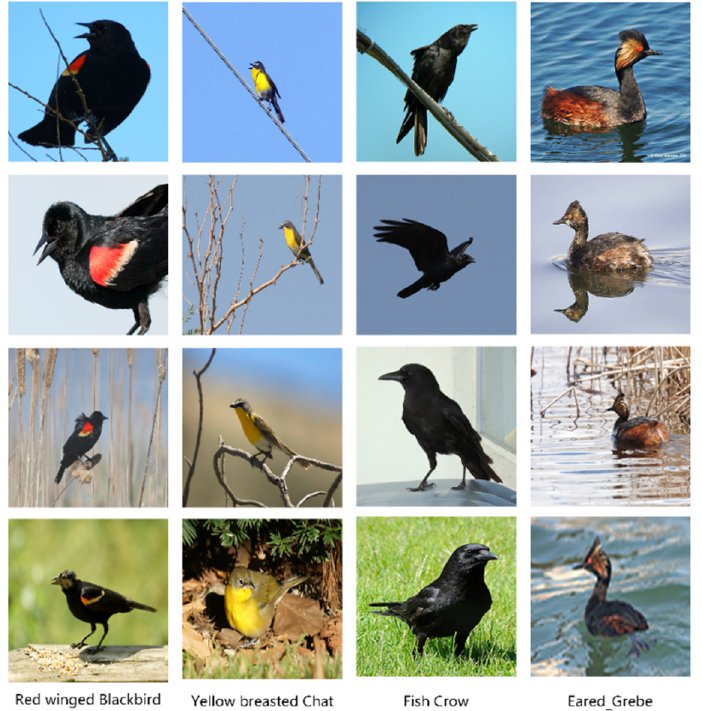
Figure 4. Images we used for visual recognition. From left to right, each column contains examples from CUB Bird.